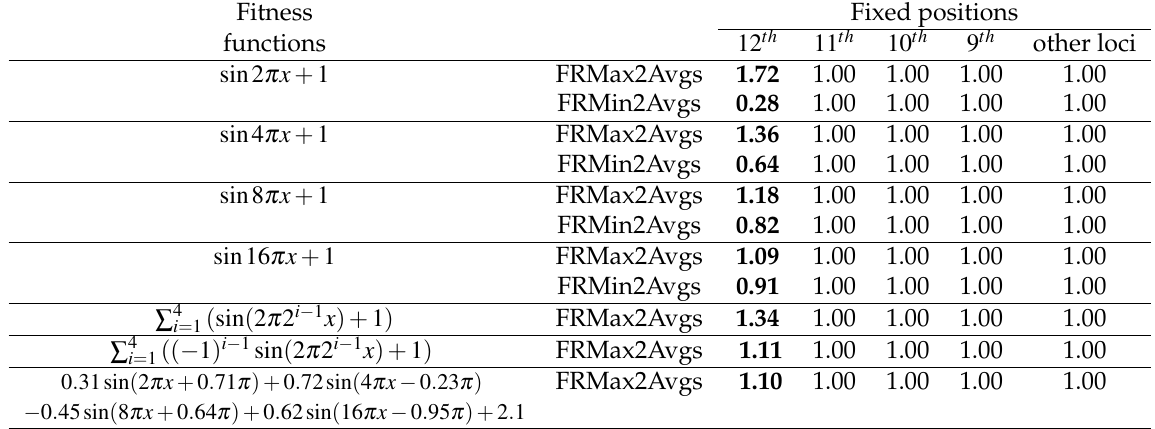
Table 2. The FRMax2Avgs and FRMin2Avgs for sin ( 2 π 2 i − 1 x )+ 1 , i ∈ { 1 , ··· , 4 } and the FR- Max2Avgs for some of their combinations under the base-3 encoding of string length 12.